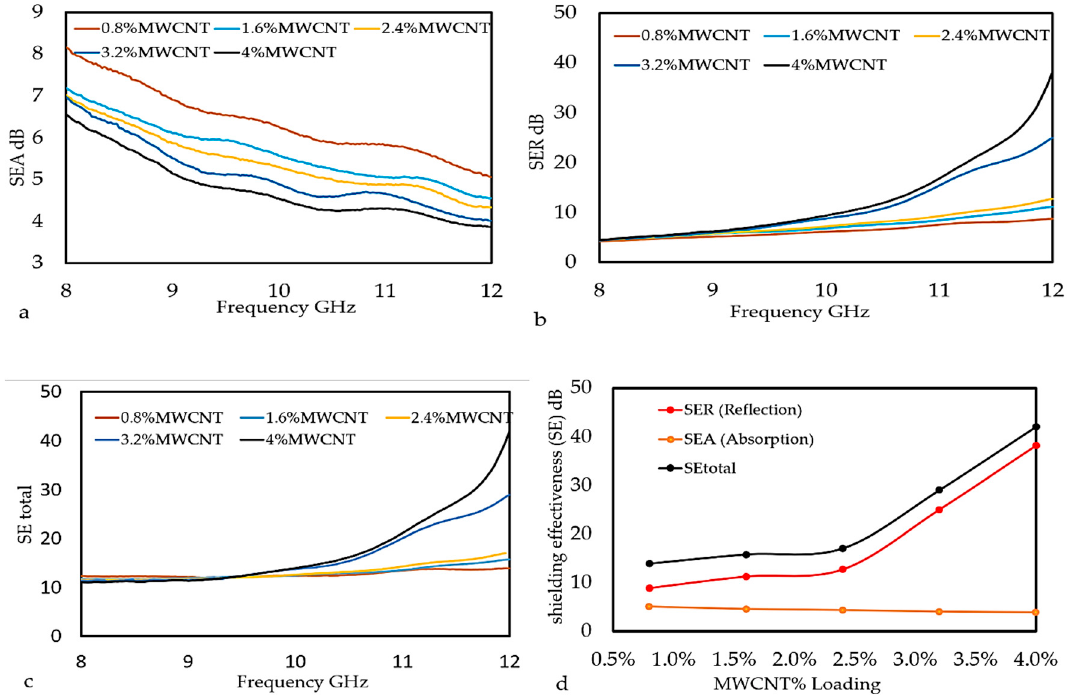
Figure 11. Variation of Shielding E ff ectiveness, ( a ) sum of the contribution due to absorption (SEA), ( b ) reflection (SER), and ( c ) shielding e ff ectiveness (SE total) as a function of frequency measured in X-band, and ( d ) Comparison of SE total, SER, and SEA as a function of MWCNTs nanoparticle loading at MWCNT/PLA/PEG nanocomposites.